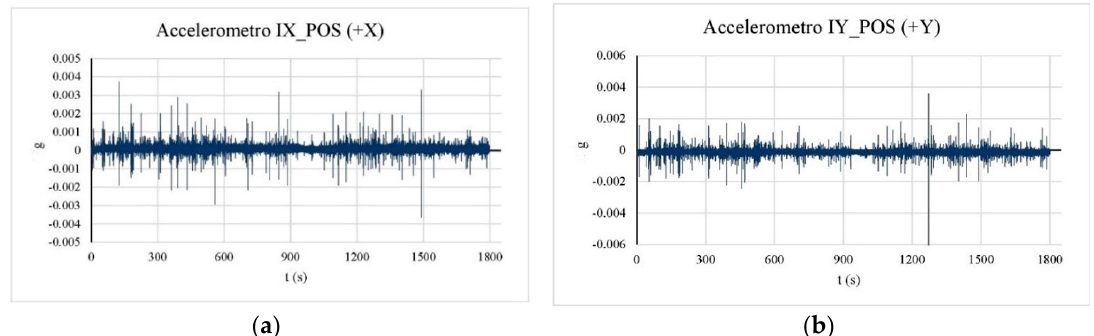
Figure 12. ( a ) Accelerometer time-history in point F, x direction; ( b ) accelerometer time-history in point F, y direction.